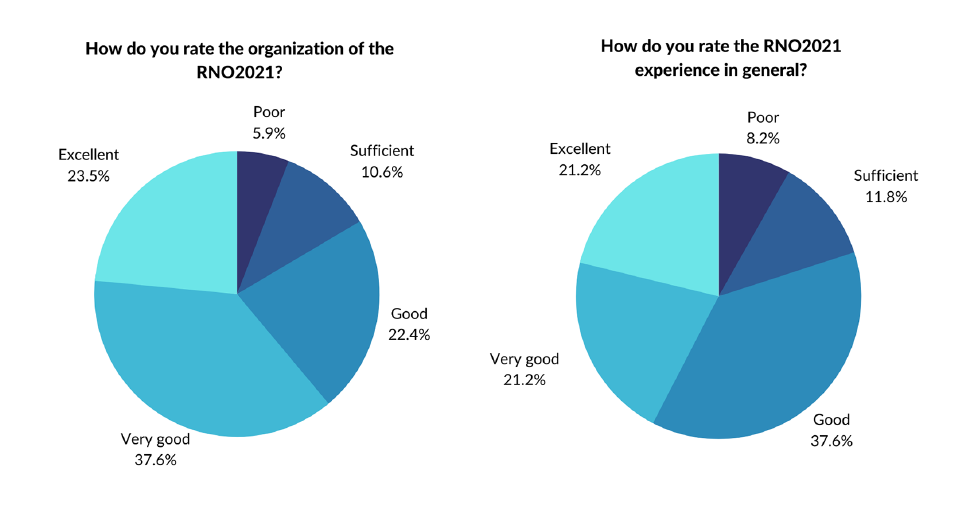
Figure 8. Post-conference satisfaction survey rating the organization and the overall experience at